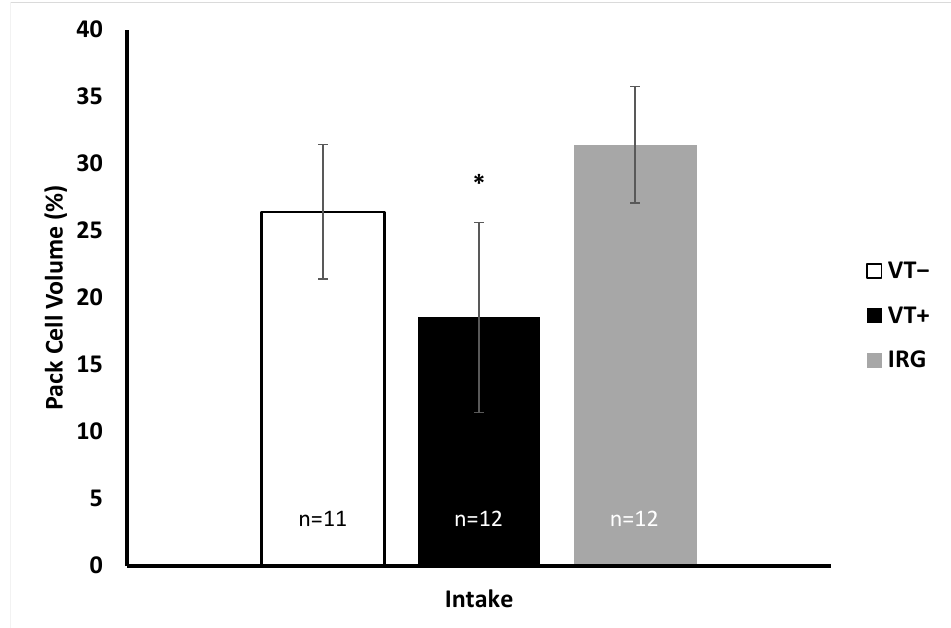
Figure 1. Intake packed cell volume (PCV) for turtles at the rehabilitation facility (VT+/VT − ) and wild-caught (IRG) turtles. * VT+ turtle PCV values were significantly different from VT − and IRG turtles ( p < 0.001). Error bars are one standard deviation from the